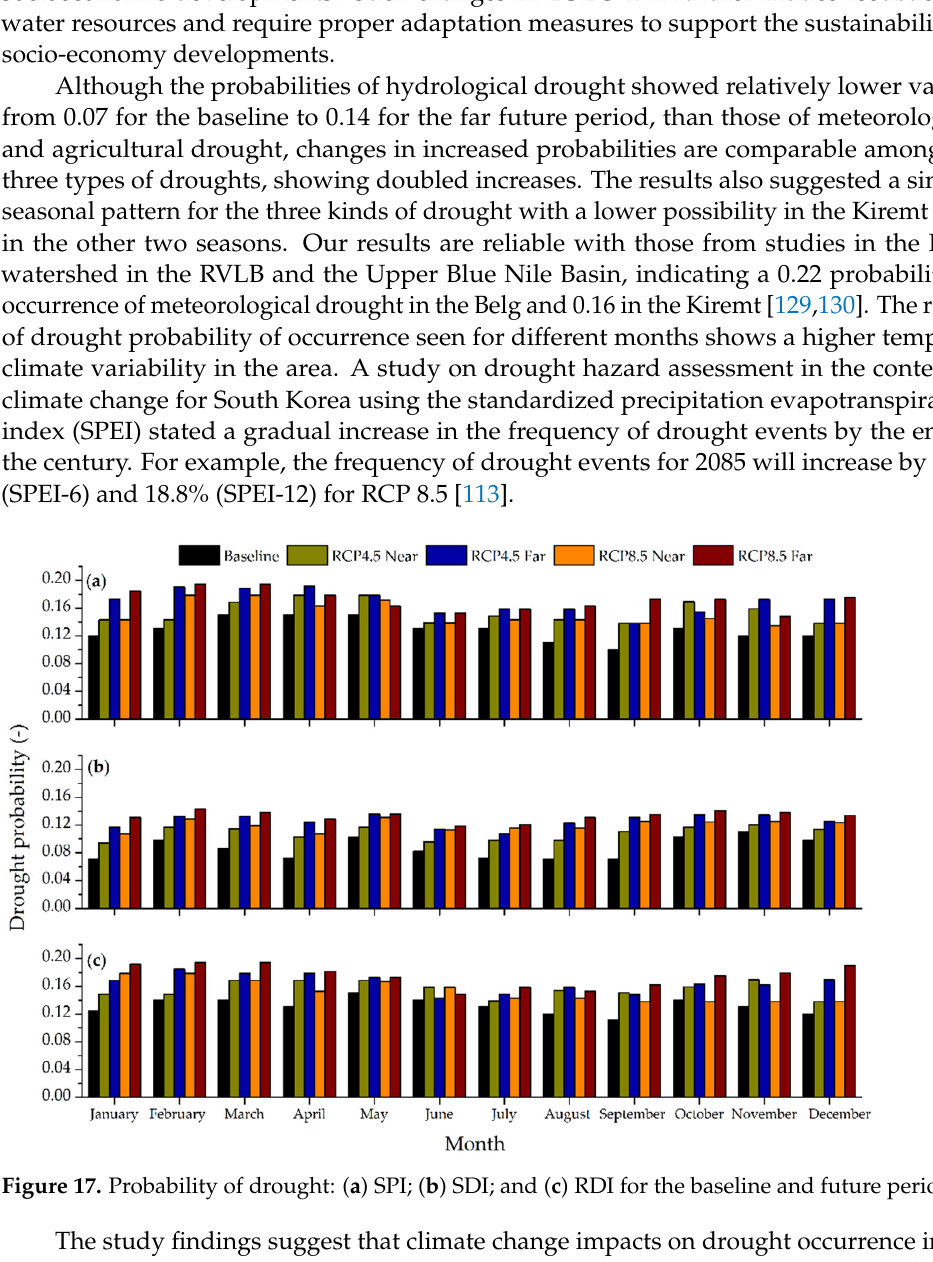
drought intensity would be − 1.69 to − 1.79 from October to May (Figure 18c).